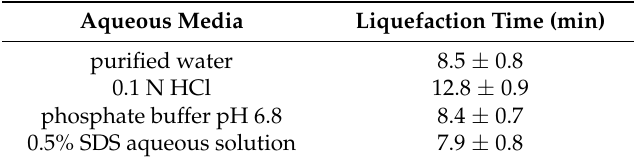
Table 6. Liquefaction time of solid self-nanoemulsifying